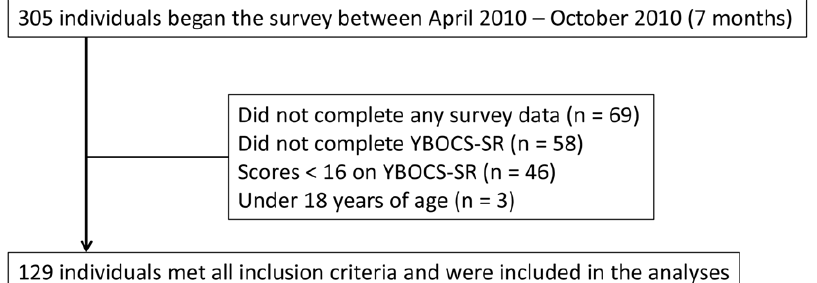
Figure 1. Survey Flow Chart.